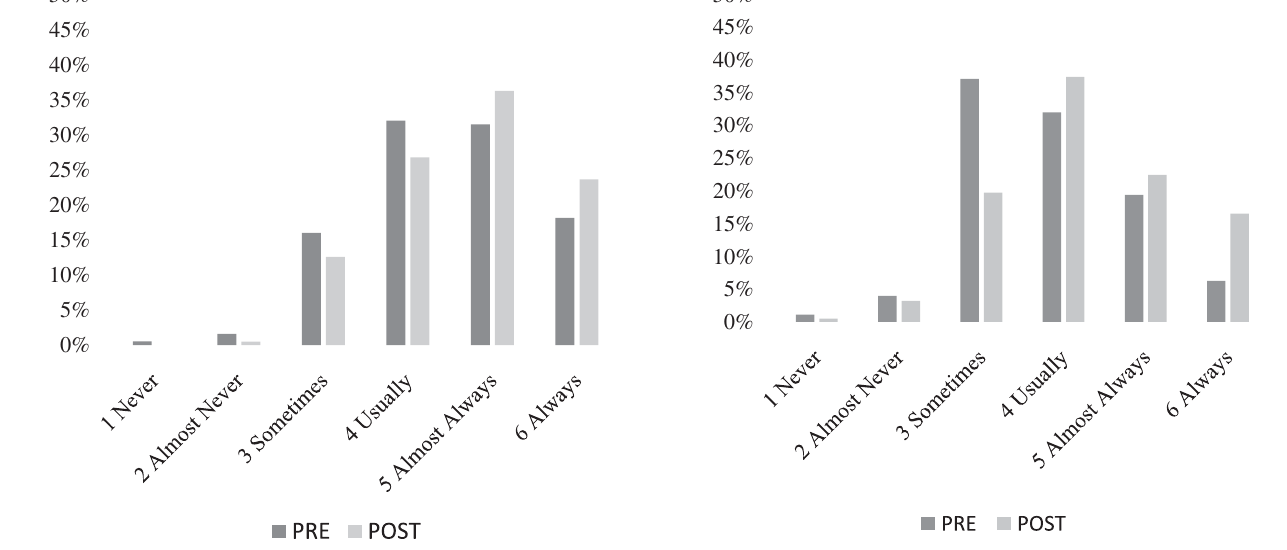
FIG. 2. The response distribution for the statement with the smallest effect size (statement 5). Dark gray bars correspond to preinstruction responses and light gray bars correspond to post- instruction responses.